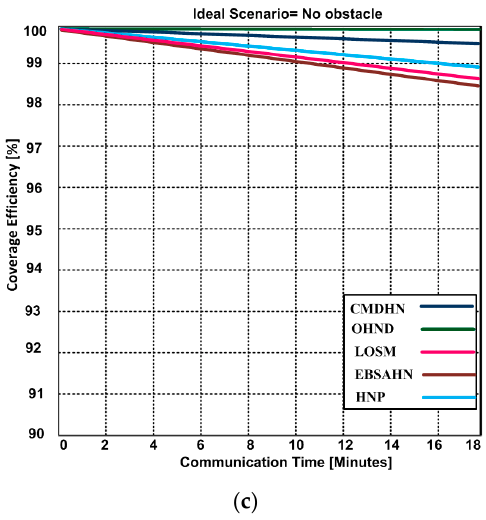
Figure 5. ( a ) multimedia converge in existence of 27 obstacles; ( b ) multimedia converge in existence of 18 obstacles; ( c ) multimedia coverage efficiency without the existence of obstacles.